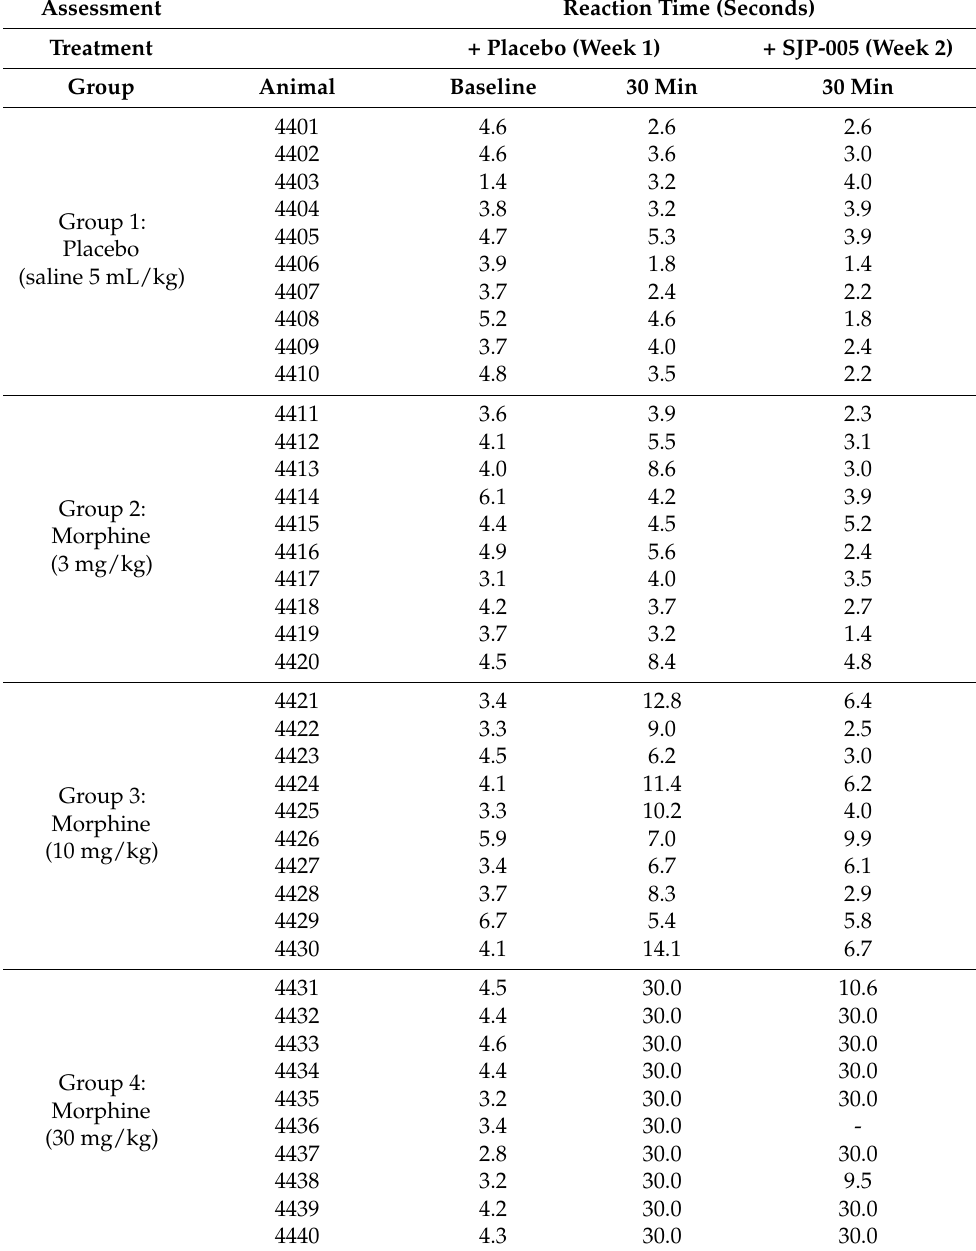
Table A2. Individual Data, Study